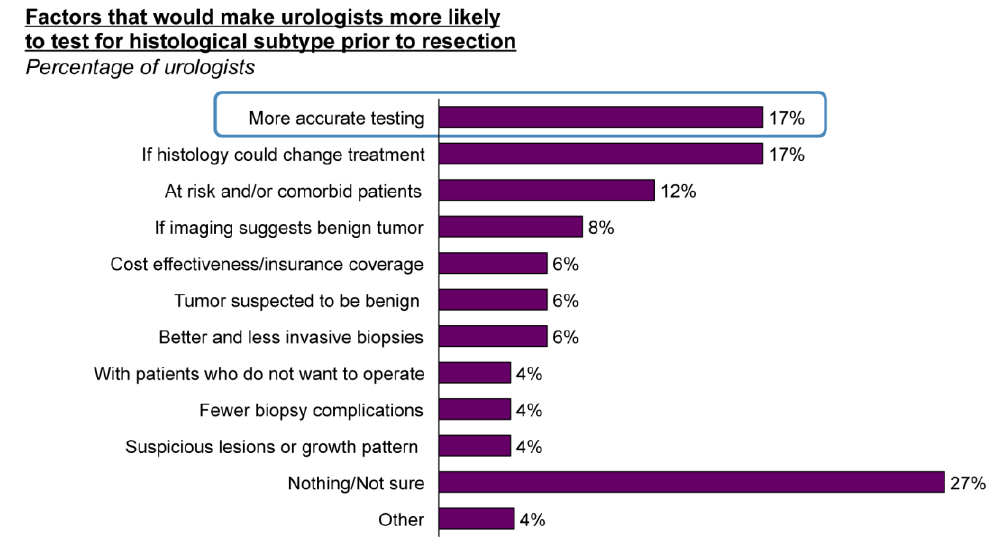
Figure 3. Factors that would make urologists more likely to biopsy.